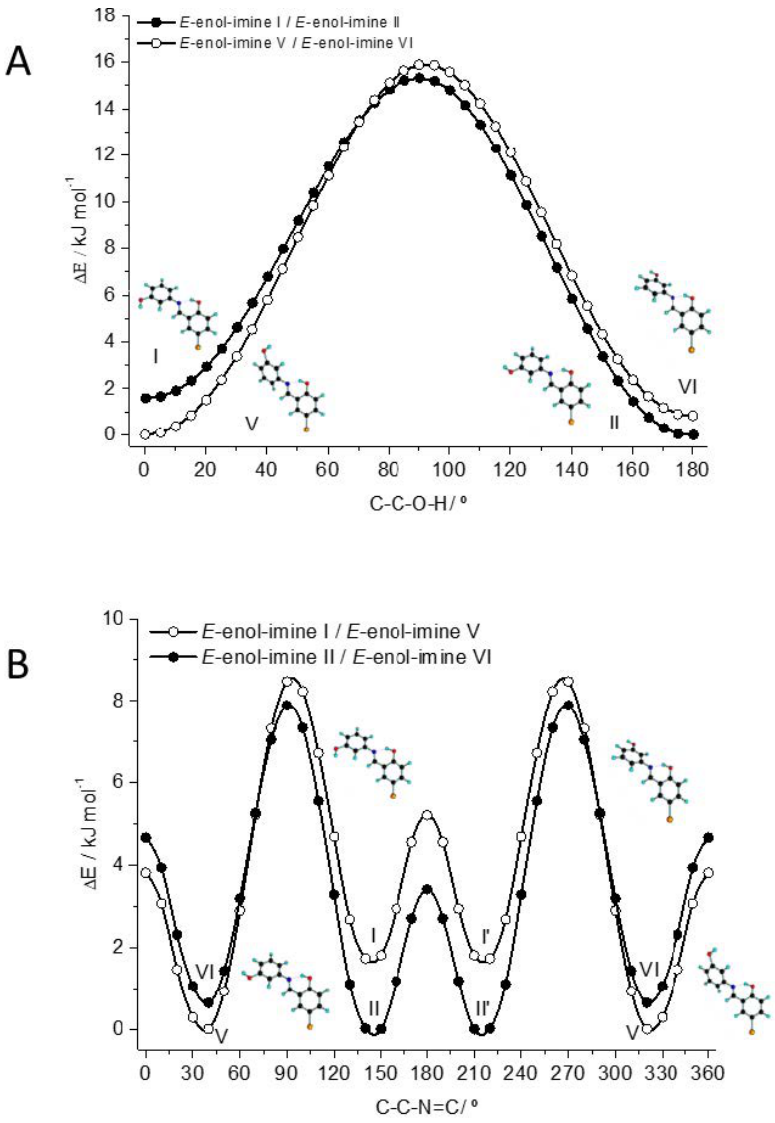
Figure 5. Potential energy profiles for interconversion between the four most stable conformers of the E -enol-imine isomer by internal rotation around the C–O bond ( A , top panel) and C5–N bond ( B , bottom panel). In B, I/I’ and II/II’ represent pairs of symmetry-equivalent conformers.